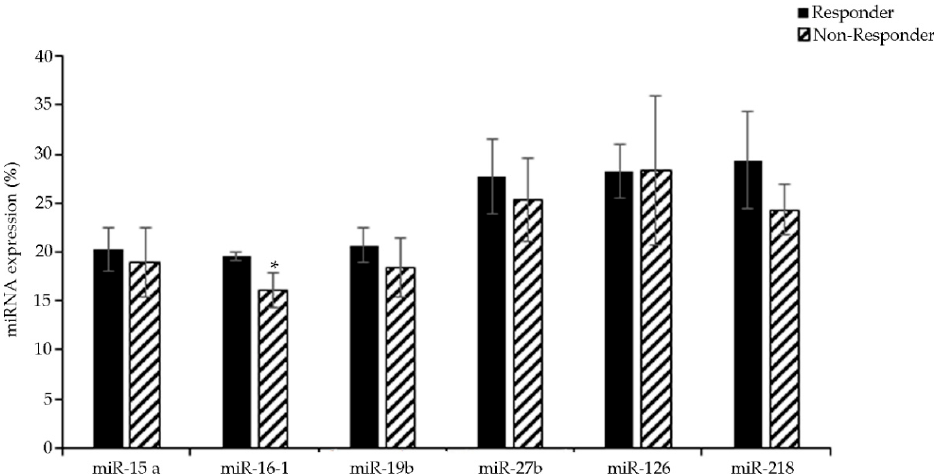
Figure 3. Evaluation of the expression levels of selected miRNAs in the bone marrow of patients sensitive (responder) or resistant (non-responder) to therapy by RT-qPCR analysis. Data is reported as % variation vs. the universal small nuclear RNU38B. * p < 0.05 vs. responder.